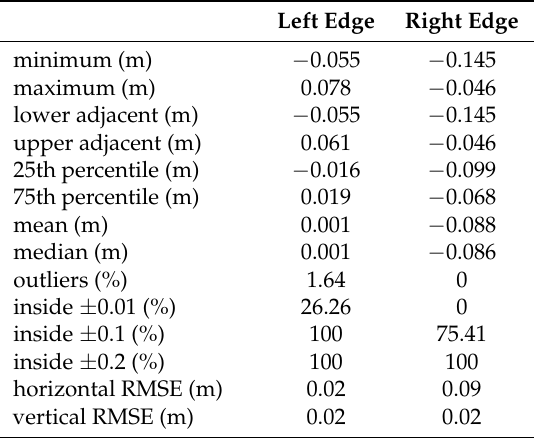
Table 1. Statistical analysis of the accuracy values of the extracted left and right edges in the road section.